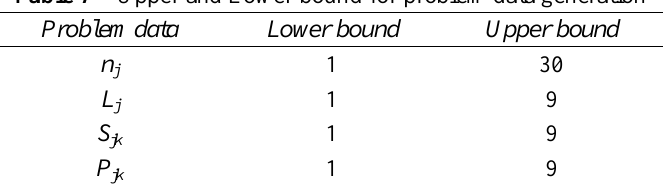
Table 7 – Upper and Lower bound for problem data